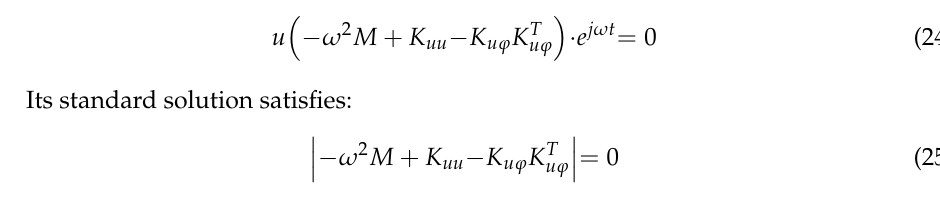
Table 1. Simulation structure parameters of the phonon piezoelectric device of the NV center.